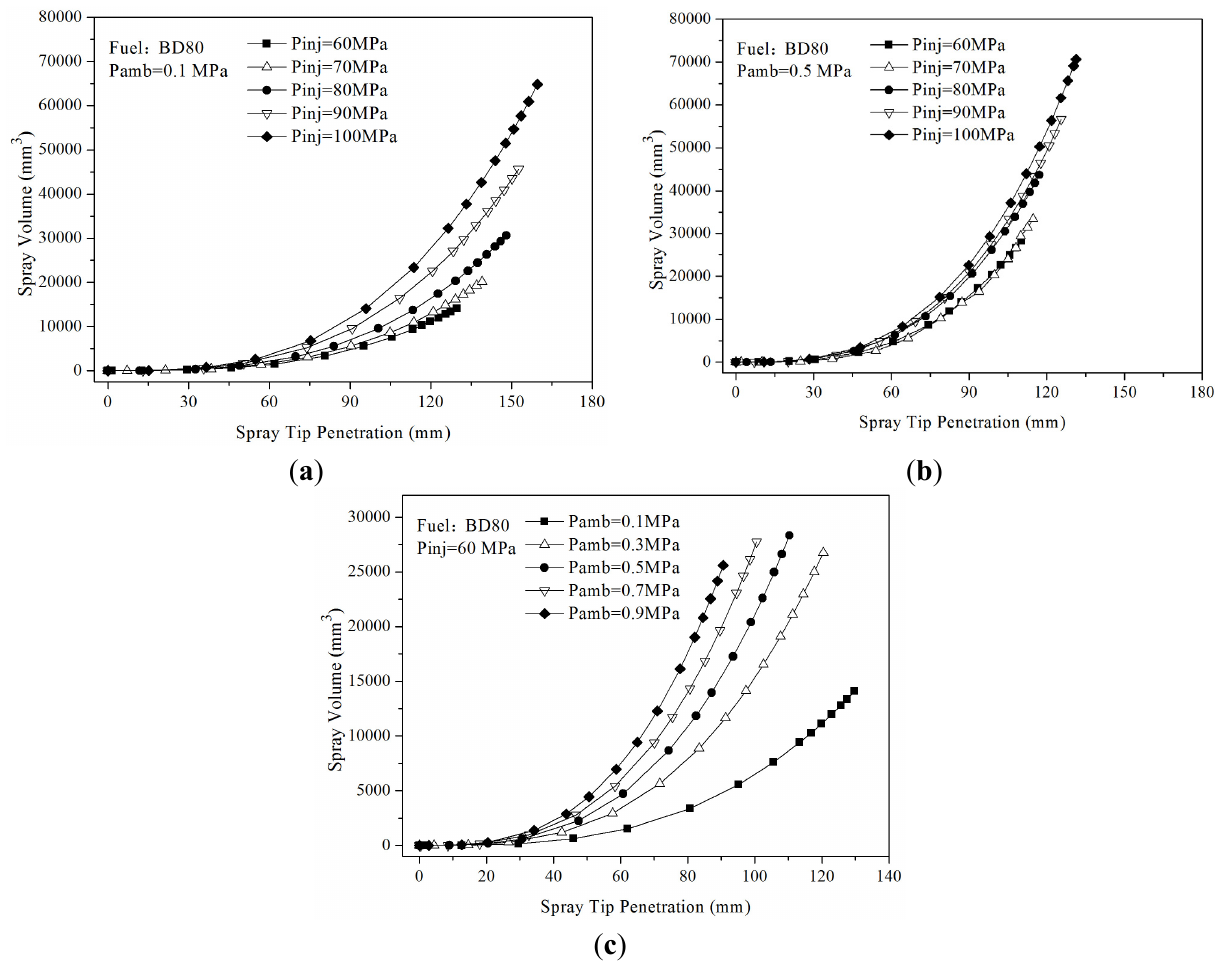
Figure 9. The spray volume for BD80 under different